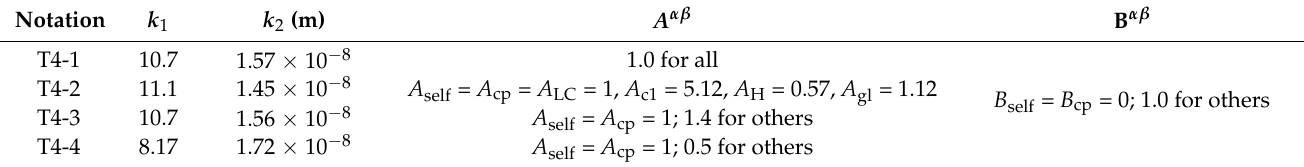
Table 3. Material parameters in crystal plasticity simulation for the T4 sheet